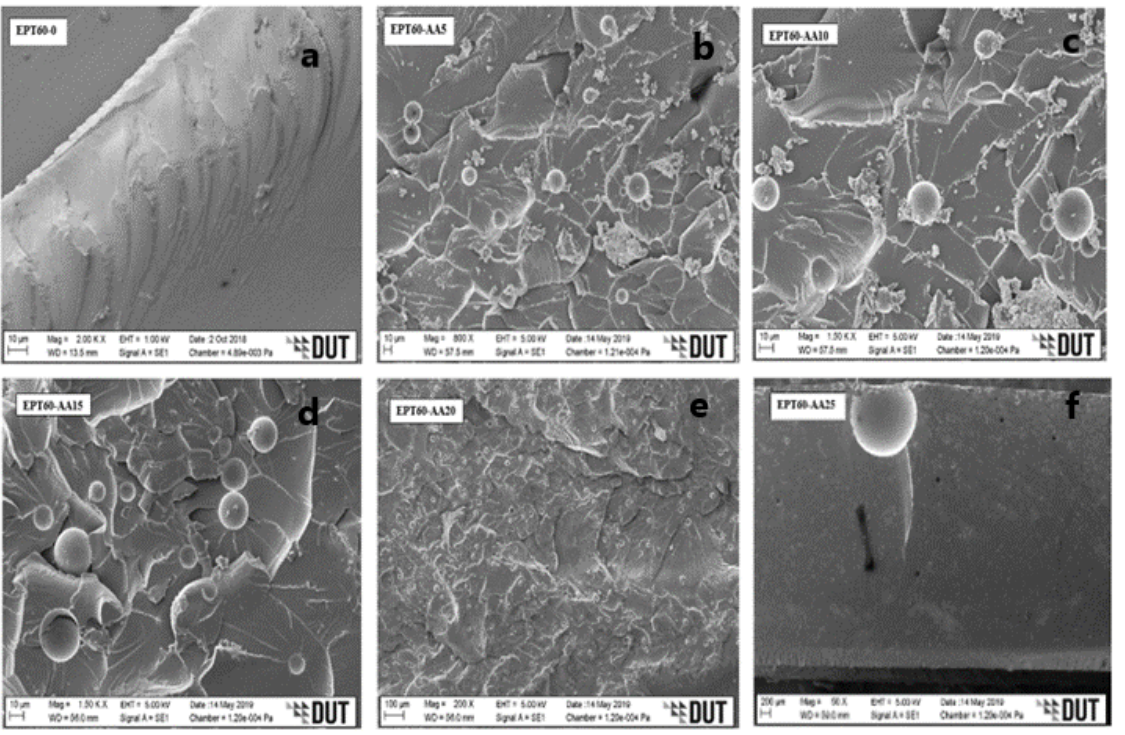
Figure 4. SEM images for flexural fractured specimens of SFC-homogenous HGM at ( a ) EPT60-0, ( b ) EPT60-AA5, ( c ) EPT60-AA10, ( d ) EPT60-AA15, ( e ) EPT60-AA20, and ( f )